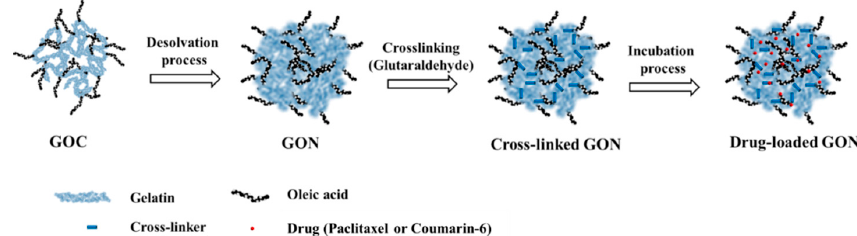
Figure 1. Schematic illustration of fattigation-platform Gelatin–Oleic Nanoparticles (GON) preparation and drug loading process.